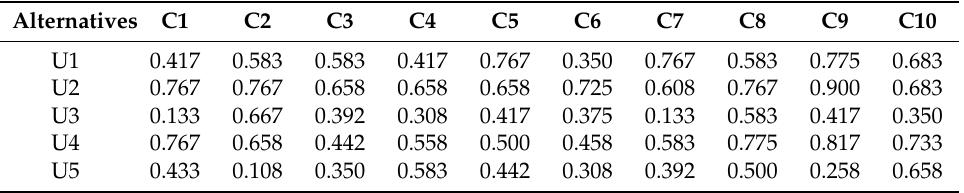
Table 15. BNP numbers of the evaluation criteria.